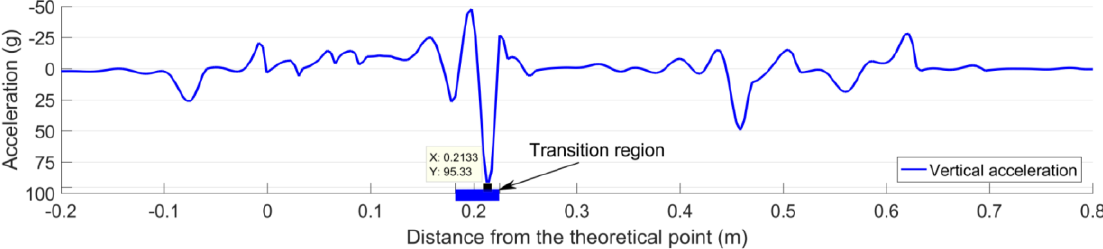
Figure 23. Rail vertical acceleration responses of a 1:9 trailing crossing in designed condition.